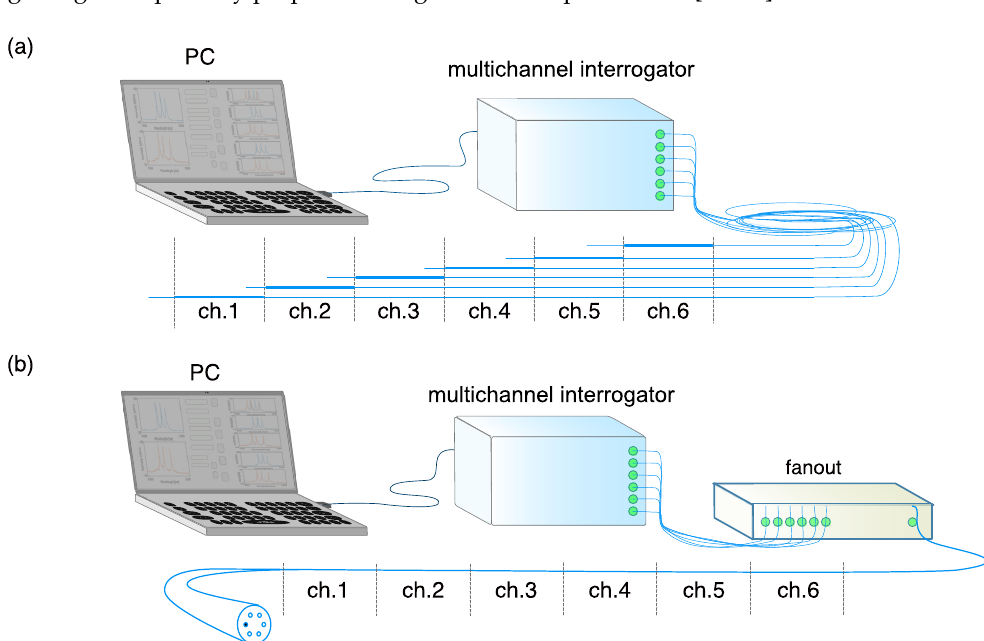
Figure 1. Optical schemes for distributed measurement beyond single optical fiber sensor spectral capacity: ( a ) sensing length extension with multiple single-core fibers; ( b ) sensing scheme based on a multicore